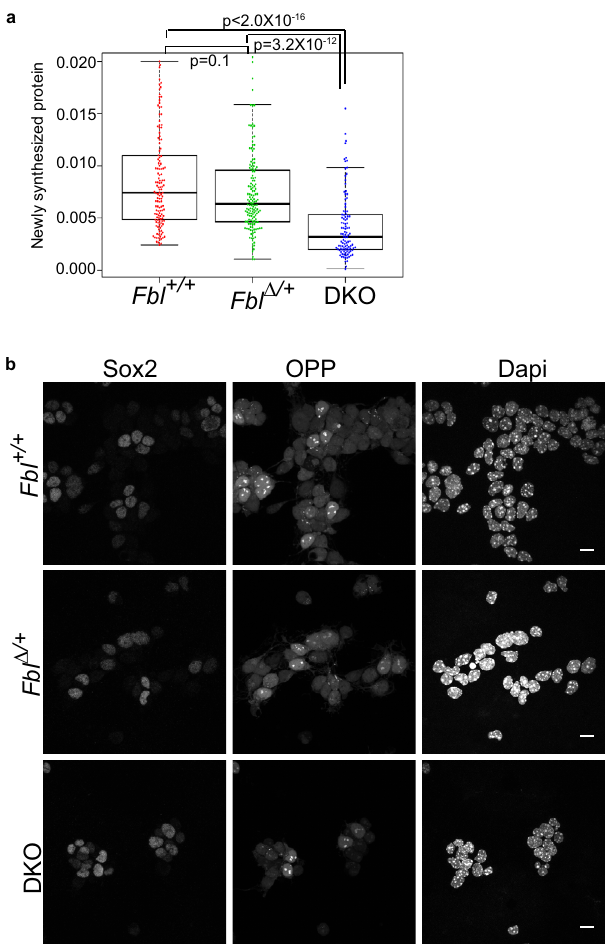
Fig. 4 Decreased levels of newly synthesized proteins in DKO neural stem cells (NSCs). a Quanti fi cation of O-propargyl-puromycin (OPP) incorporation in NSCs (Kruskal – Wallis test and Dunn ’ s test with Bonferroni correction; Fbl + / + : n = 135; Fbl Δ / + : n = 148; DKO: n = 106). Data in the box – whiskers show maximum, third quartile to fi rst quartile, and median and minimum. b Representative image of cultured cells stained for Sox2/ OPP/Dapi. Scale bar: 10 µ